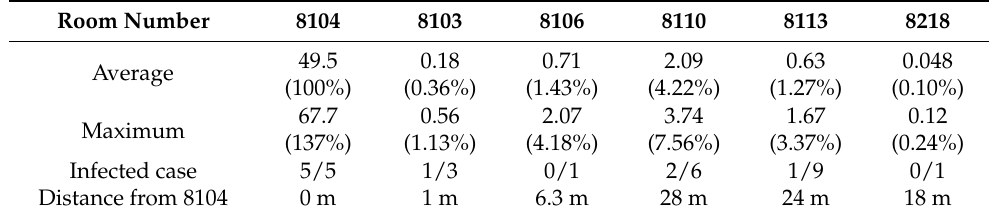
Table 1. Average concentration of SF6 in patient rooms (ppm). The values in parentheses indicate the ratios of the SF6 concentration to the average concentration in room 8104.